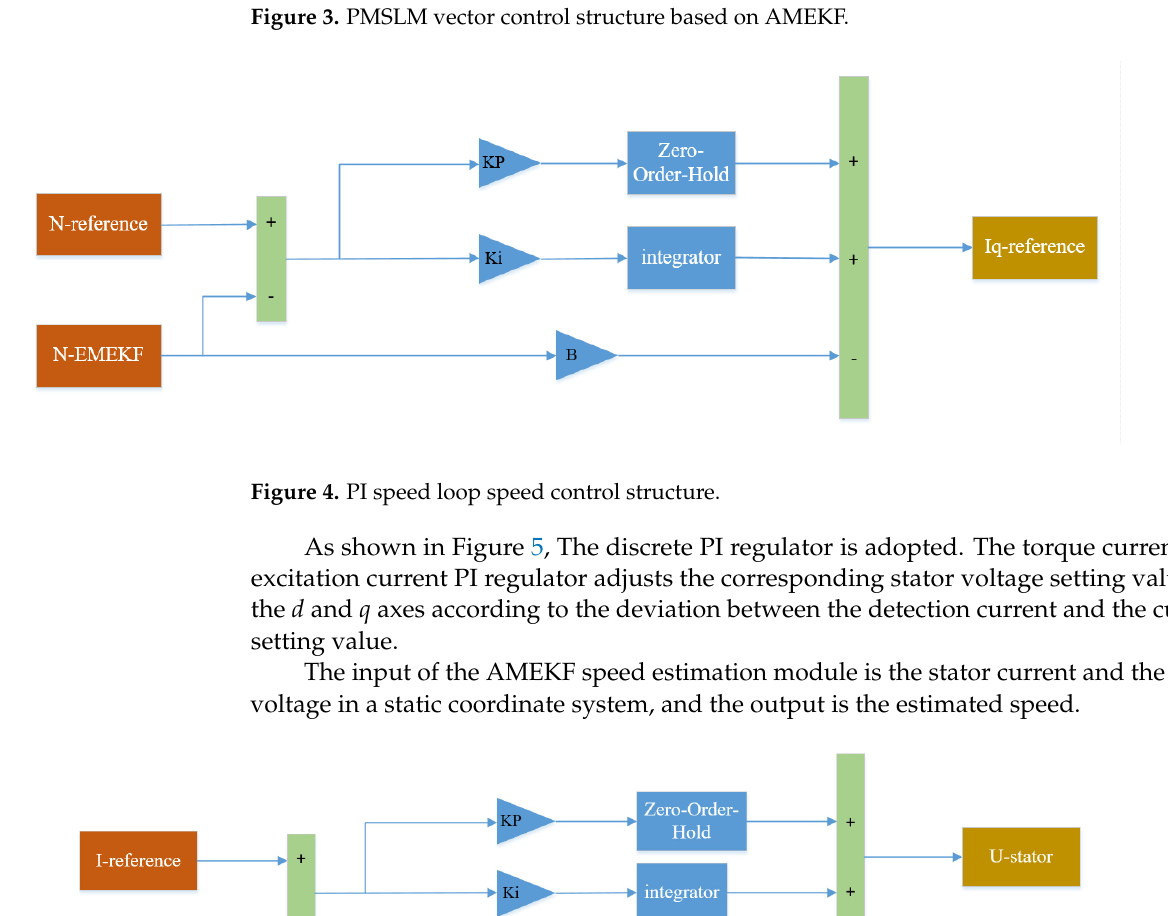
Figure 5. PI current loop speed control structure.